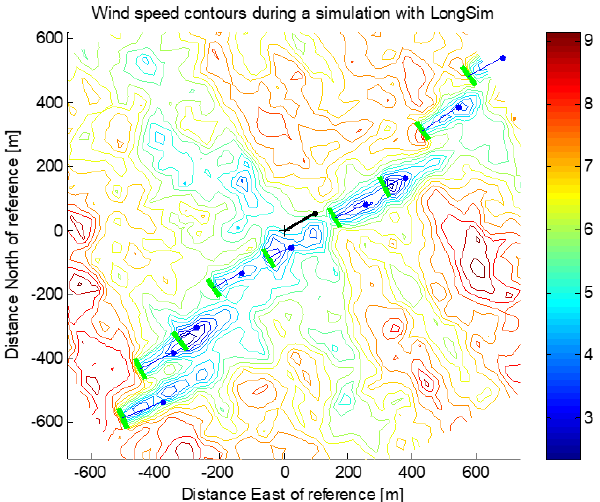
Figure 2. Typical wind speed contour plot from a LongSim dy- namic simulation. Rotor planes of nine turbines, nos. 13 and 31 to 38, of the Sedini wind farm are represented as thick green lines, with blue lines pointing along the local wind direction with length proportional to the local wind speed